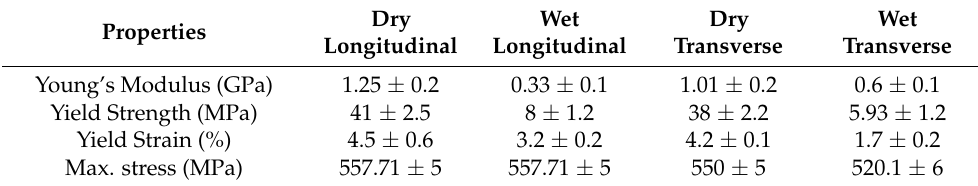
Table 9. Compressive properties of Deccani sheep